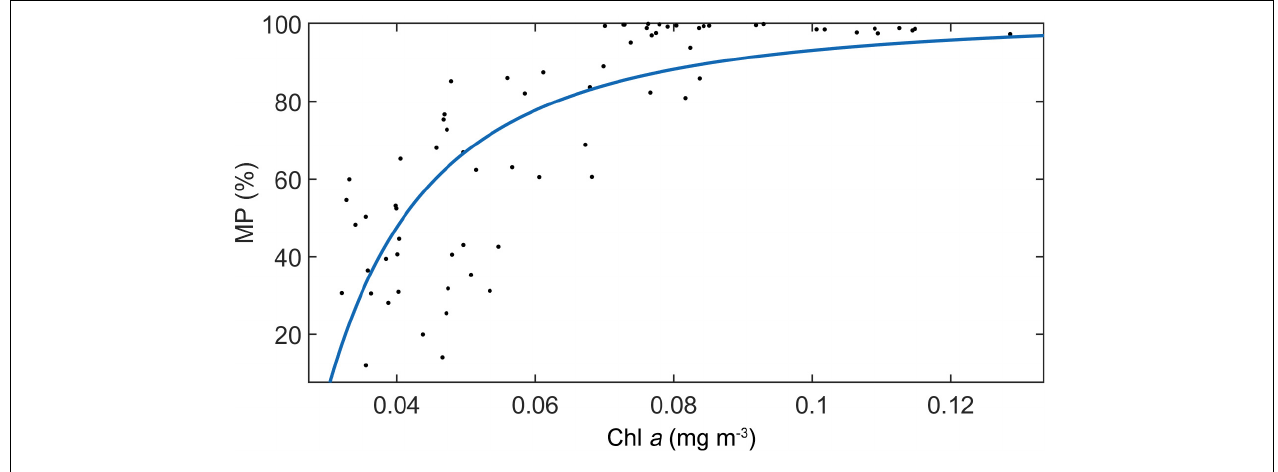
FIGURE 7 | The relationship between MP and Chl a concentration along the ship-track in study area. A regression line was